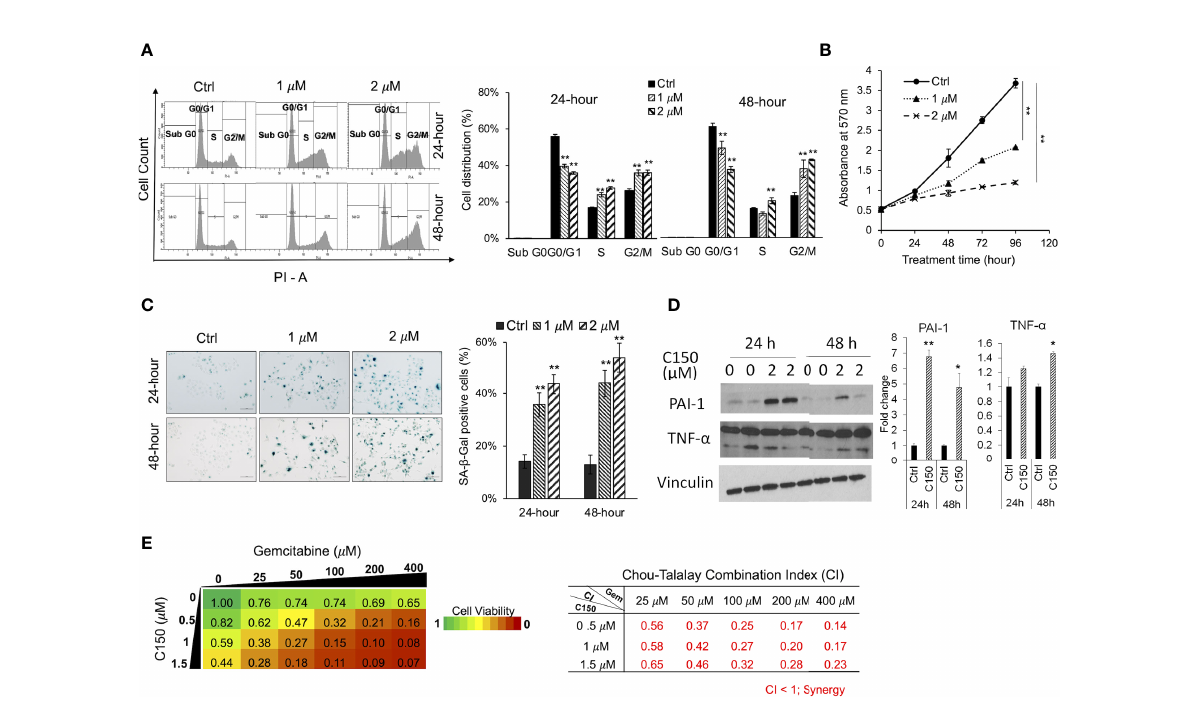
FIGURE 3 C150 caused G2/M cell cycle arrest, cellular senescence, and synergized with gemcitabine in PANC-1 cells. (A) Cell cycle analysis. PANC-1 cells were treated with DMSO (Ctrl) or C150 (1 m M and 2 m M) for 24 and 48 h. Cells were stained with propidium iodide (PI) and analyzed for cell cycle distributions with fl ow cytometry. Bar graph shows the quanti fi cation of the percentage of cells in each cell cycle. Data presented as mean ± SD of three independent experiments. (B) Cell growth curve. PANC-1 cells were seed at 5,000 cells per well in 96-well plates in triplicates and treated for 0, 24, 48, 72, and 96 h. Viable cells were detected by MTT assay. Data presented as mean ± SD of three experiments. (C) SA- b -galactosidase staining at pH 6.0 for cell senescence. Senescent cells were identi fi ed by the green-blue staining under bright fi eld light microscopy at